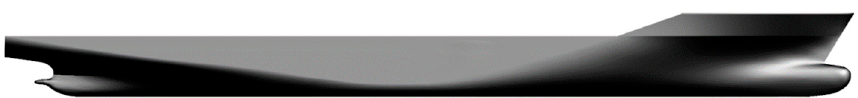
Table 1. The main particulars of Kriso Container Ship (KCS).